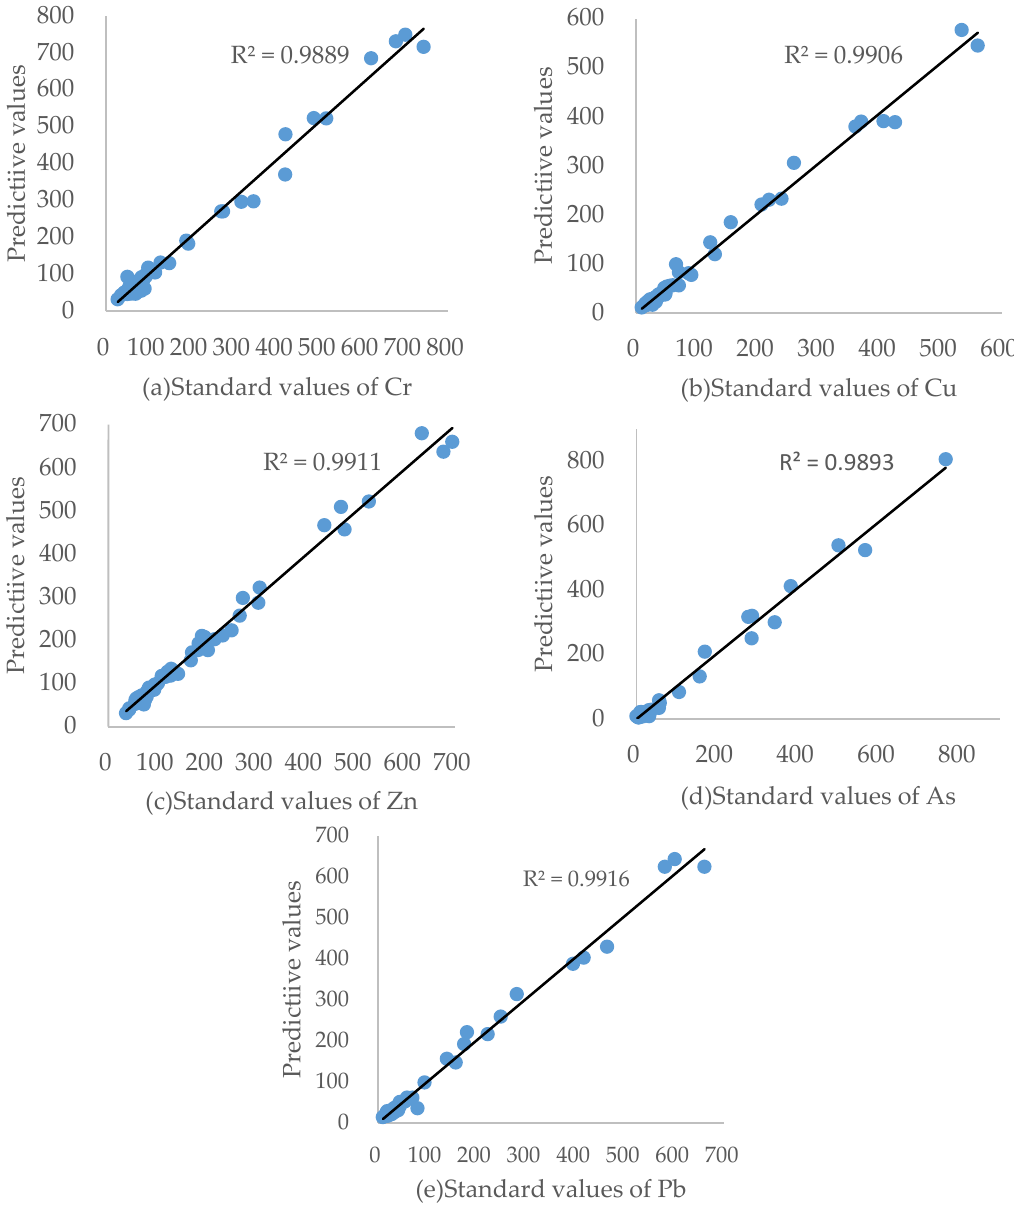
Figure 7. Relationship between standard values measured by chemical analysis and predictive values detected by XRF spectrometer for Cr ( a ), Cu ( b ), Zn ( c ), As ( d ) and Pb ( e ). Spectral data were pre-processed with DWT.